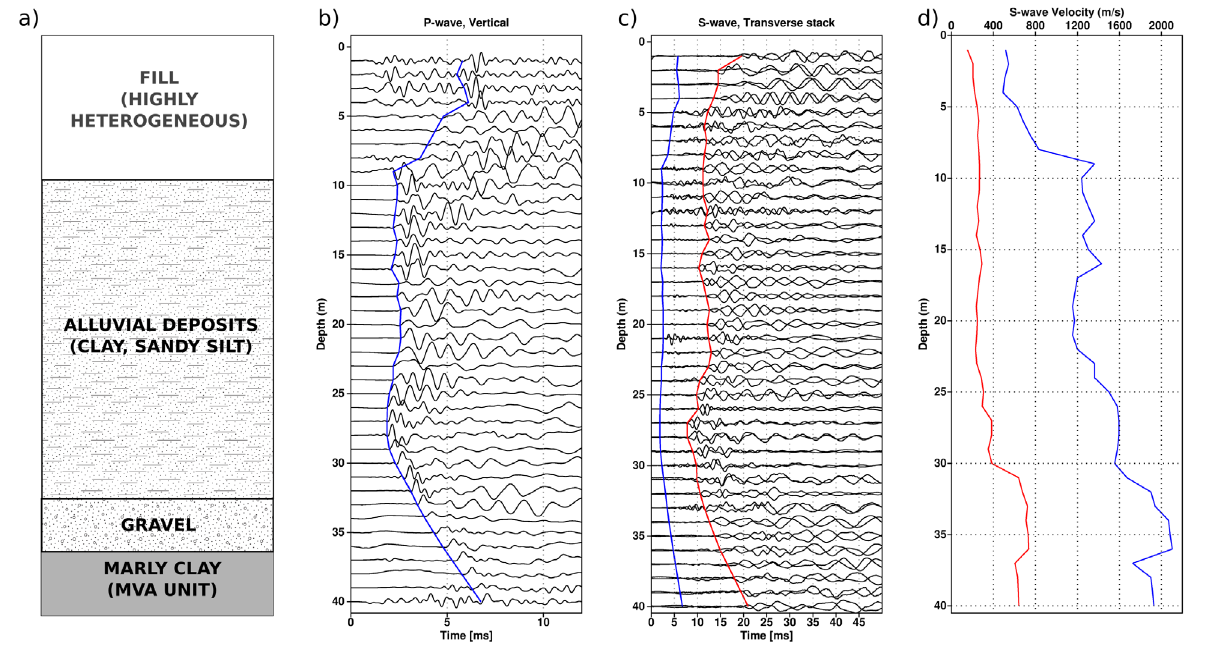
Figure 4. Borehole seismic at the Colosseum. (a) Simplified stratigraphic column of the SB borehole. (b) P-wave records (vertical compo- nent): the blue line indicates the first arrivals. (c) S-wave records (transverse component). For each receiver position, the two traces corre- sponding to the opposite shot directions are superimposed; the red and blue lines show the S-wave and the P-wave arrivals respectively. (d) The P-wave and S-wave velocity profiles.